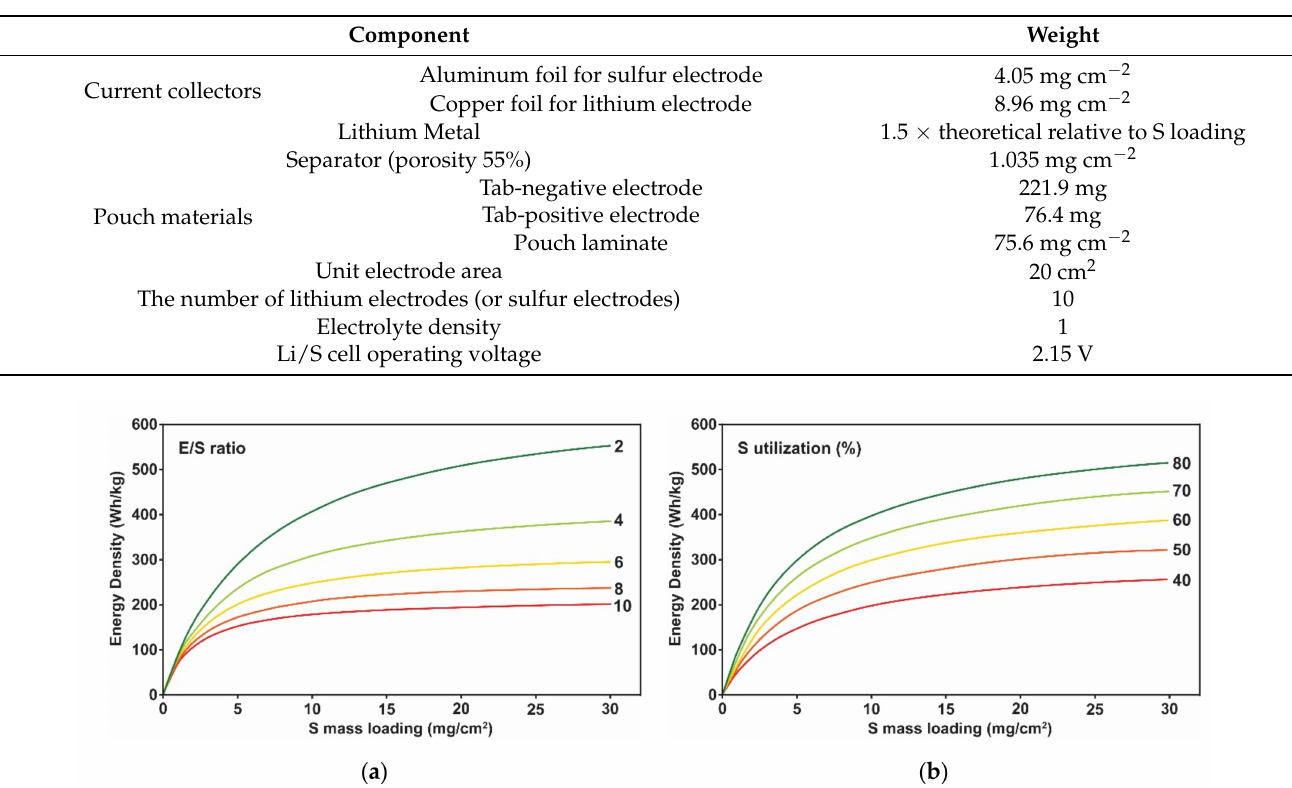
Table 1. Approximate values for the pouch cell components. A double-side coated sulfur electrode and lithium electrode were considered.